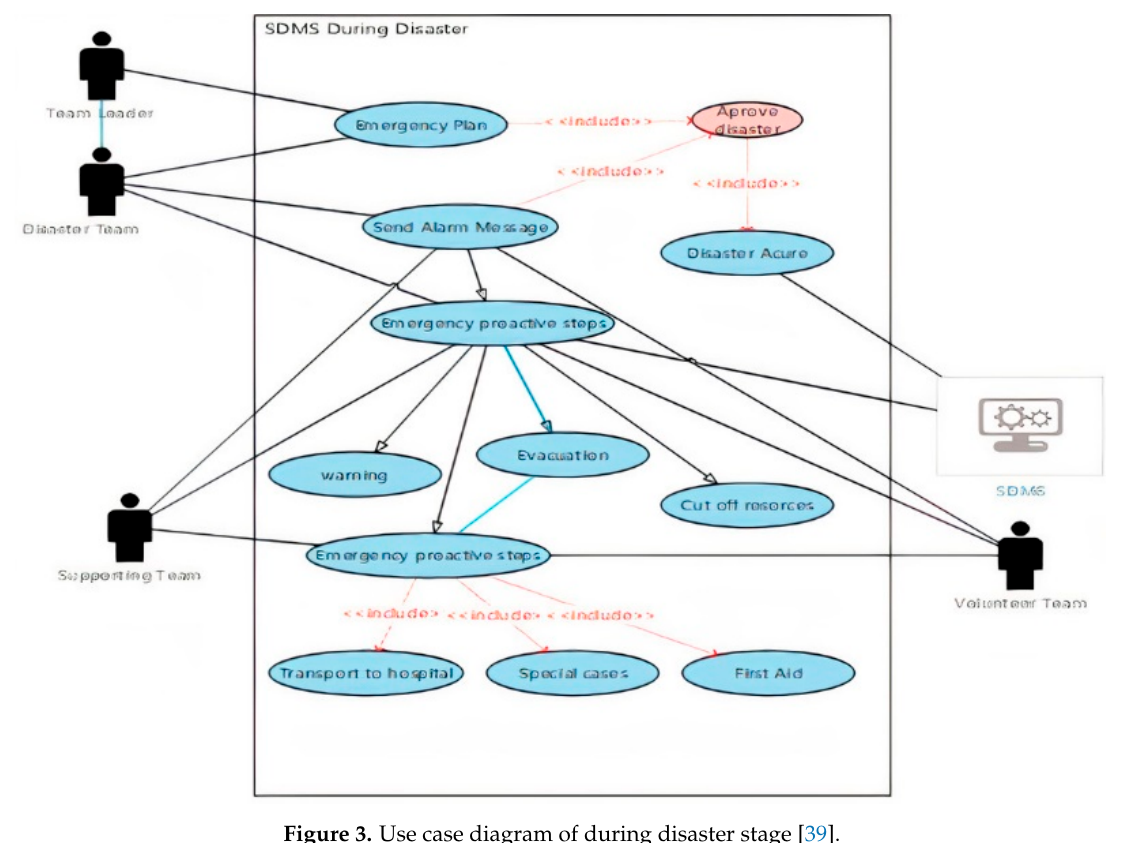
Figure 3. Use case diagram of during disaster stage [39].